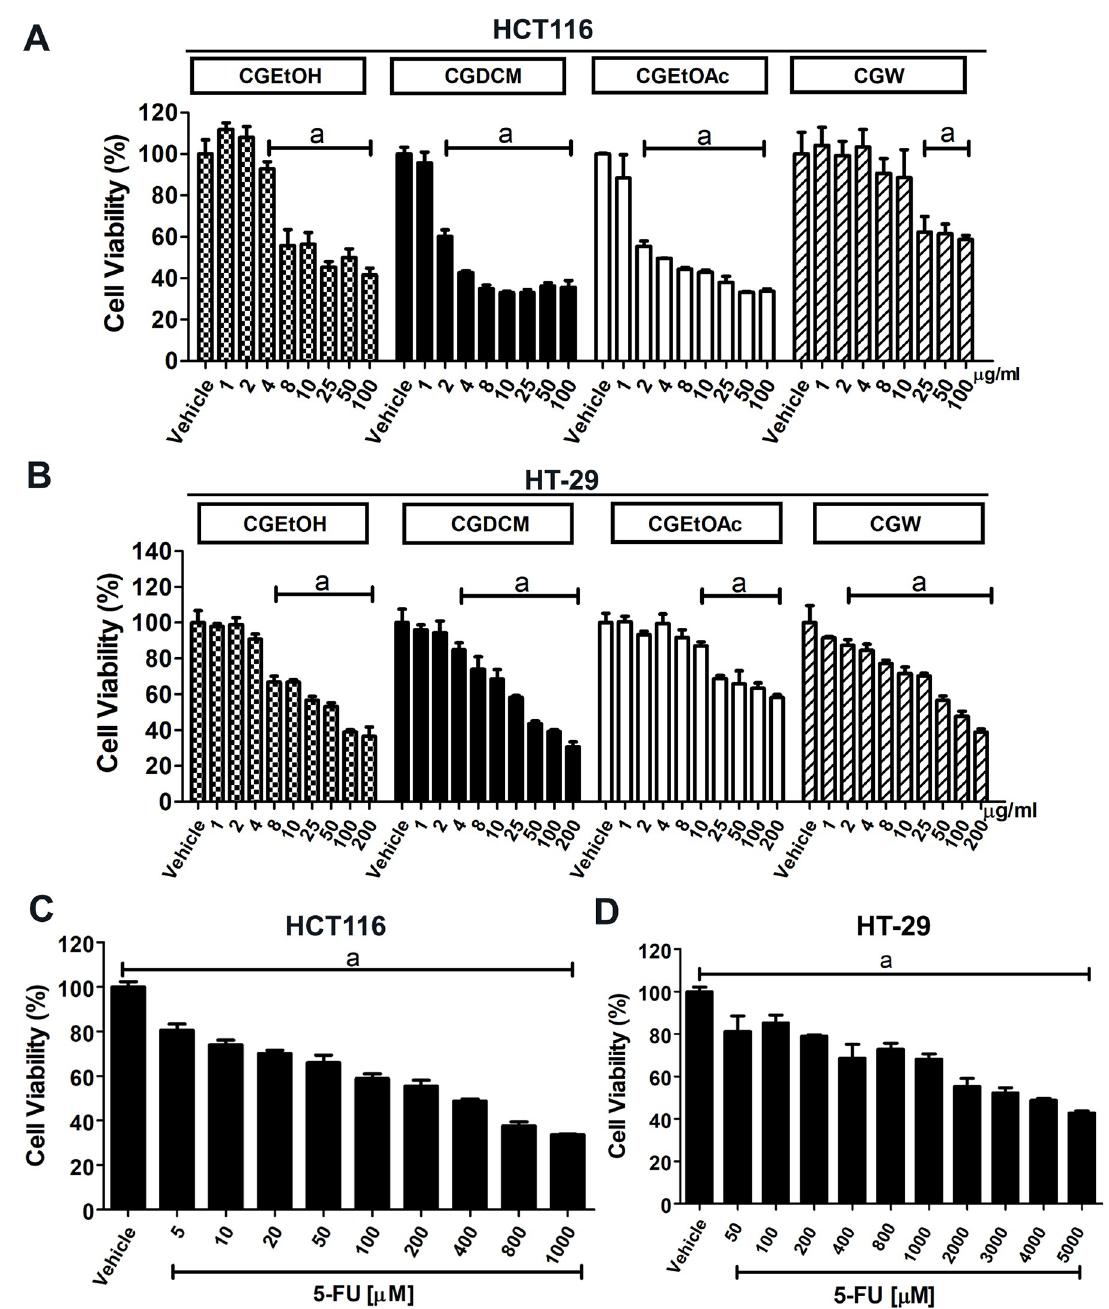
Fig 1. Cytotoxic effects of Calotropis gigantea stem bark extracts on HCT116 and HT-29 cells. The viability of HCT116 (A) and HT- 29 (B) cells, evaluated by MTT assay. The vehicle control group was 0.8%DMSO. The effect of the positive control, 5-FU, on HCT116 (C) and HT-29 (D) cells. The data are presented as mean ± SD from a minimum of three independent experiments, and were analyzed using one-way ANOVA with Tukey’s HSD test. � p < 0.05 compared with the vehicle. Abbreviations: CGEtOH, C . gigantea ethanolic extract; CGDCM, C . gigantea dichloromethane extract; CGEtOAc, C . gigantea ethyl acetate extract; CGW, C . gigantea water extract; 5-FU, 5-fluorouracil.